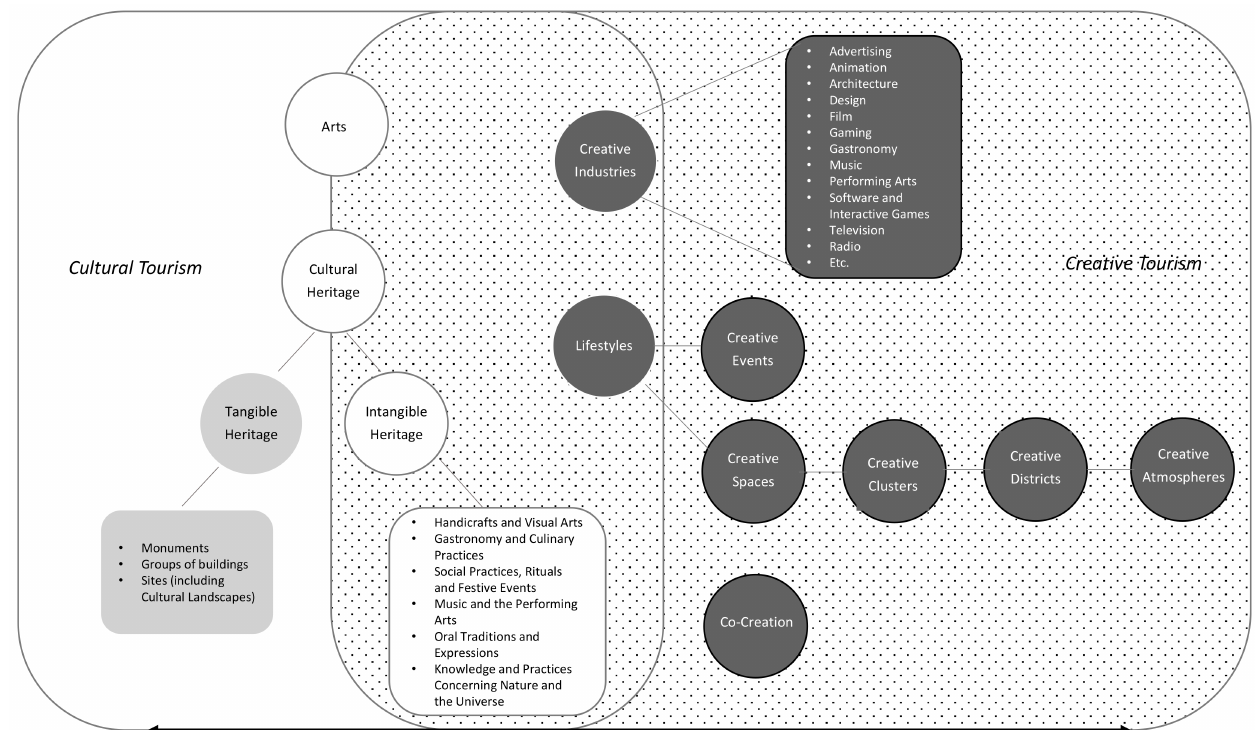
Figure 2. Key elements of cultural and creative tourism. Source: own